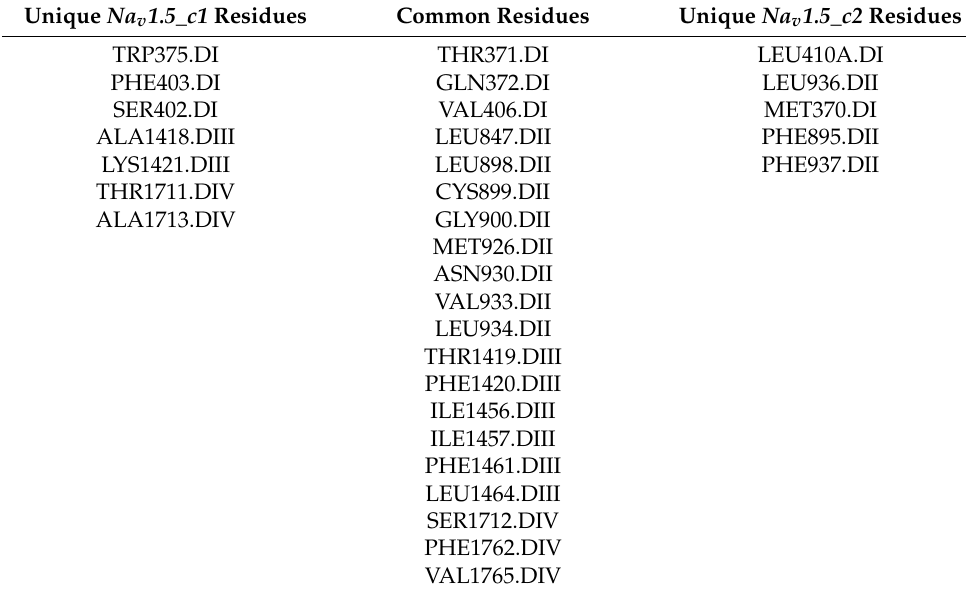
Table 2. BS residues of Na v 1.5 centroids. Description of the binding site residues from centroid structures in Na v 1.5 obtained by clustering based on physicochemical properties. For Na v 1.5, centroid structures correspond to Na v 1.5_c1 and Na v 1.5_c2 from clusters 1 and 2, respectively.